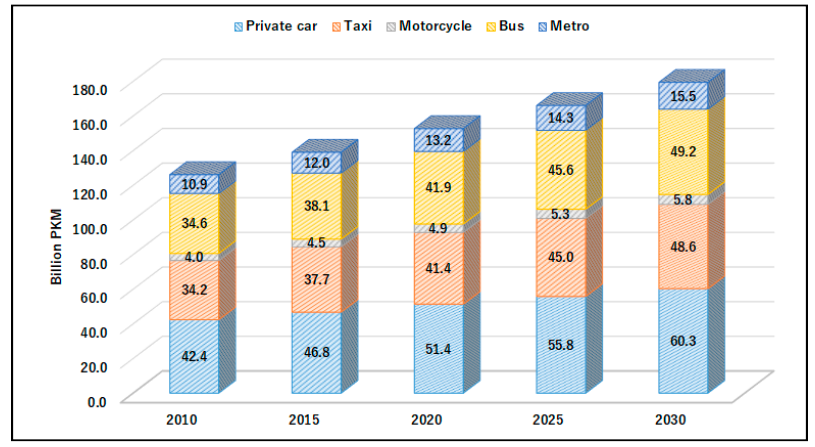
Figure 5. Baseline projection of travel demand estimated at the maximum sat. levels.